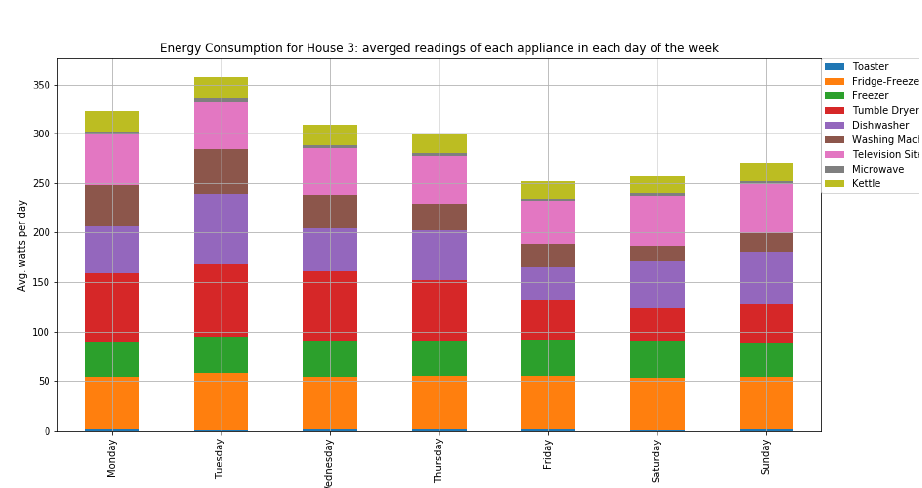
Figure A15. The average consumption per day of home appliances for house 3 with two